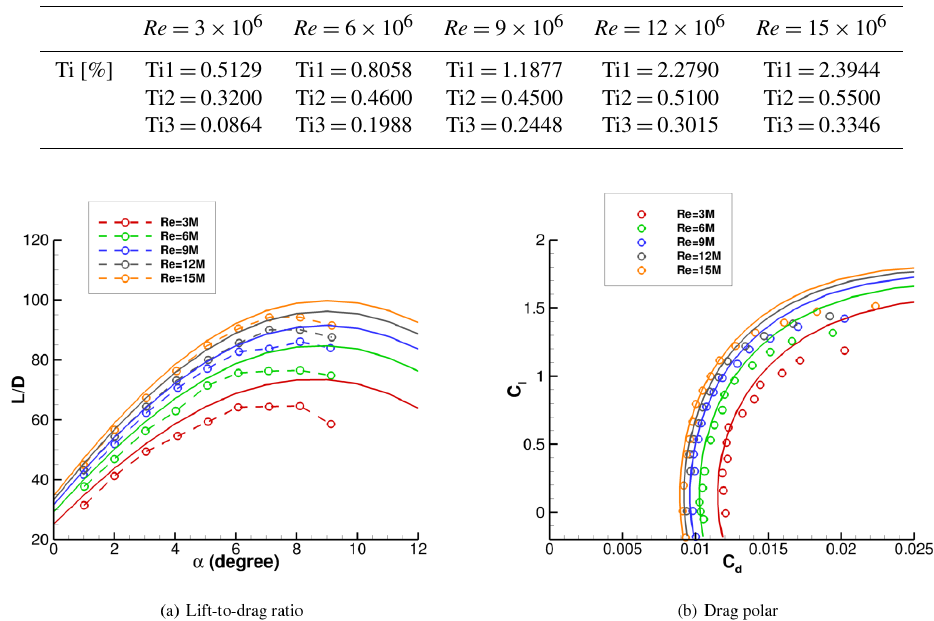
Figure 5. Comparison of (a) lift-to-drag ratio and (b) drag polar predicted by HAM2D using fully turbulent flow approximation for the DU00-W-212 airfoil against experimental data from Pires et al. (2016) with a tripped boundary